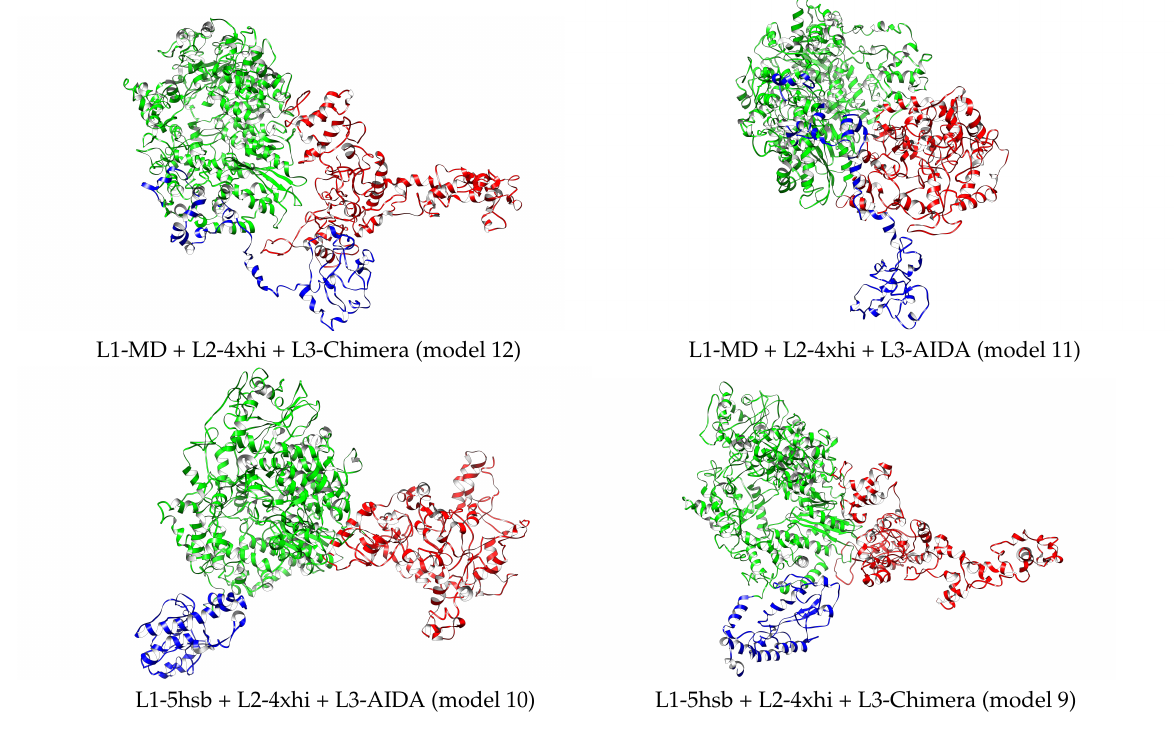
Figure 5. Best four relaxed structures based on L-protein energetics reported in Table 4. L1, L2, and L3 domains depicted in blue, green, and red, respectively. Drawn with Chimera